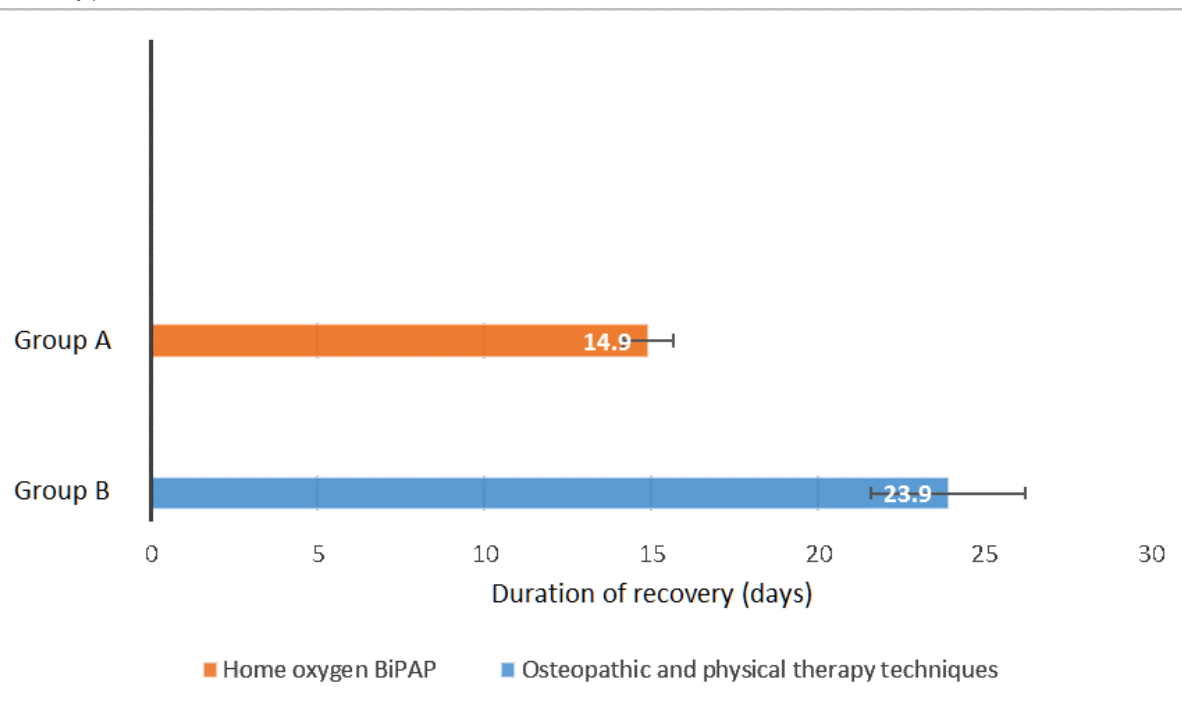
Figure 2. Number of days needed for Group A and Group B to recover. Values and whiskers on bars are means and SDs, respectively. BiPAP: bilevel positive airway